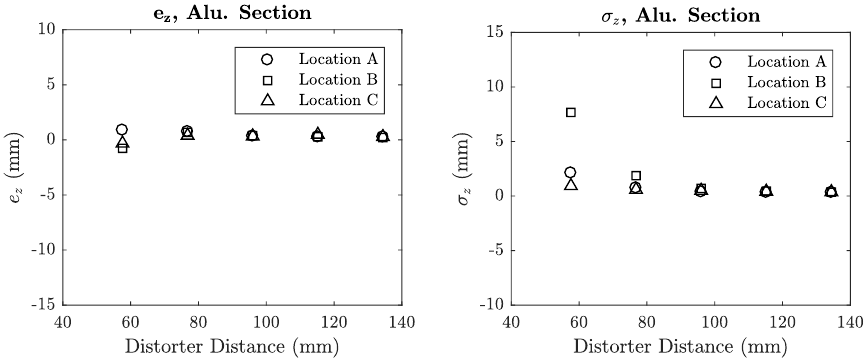
Figure 17. Mean error and standard deviation for aluminium section distorter in locations A, B and C.